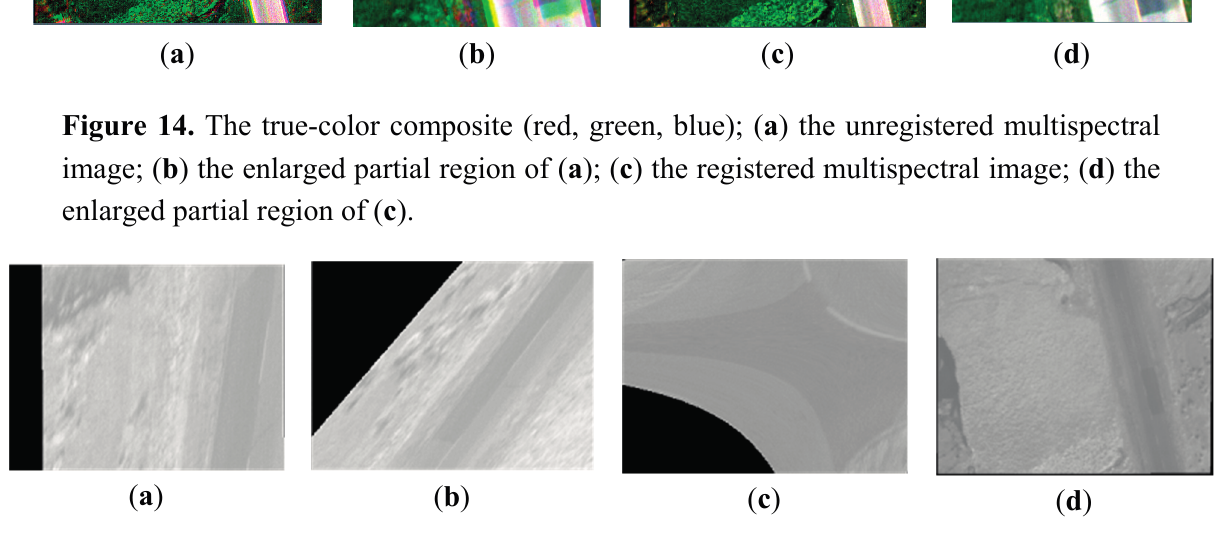
Figure 15. The single infrared bands of the multispectral images; ( a – c ) respectively the infrared bands obtained by using the methods using the first-order polynomial, second-order polynomial and homography mode and using the RANSAC directly; ( d ) the infrared band obtained by using our